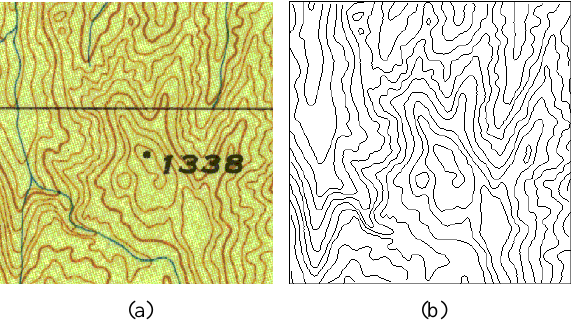
Figure 12. A part of another topographic map with forest